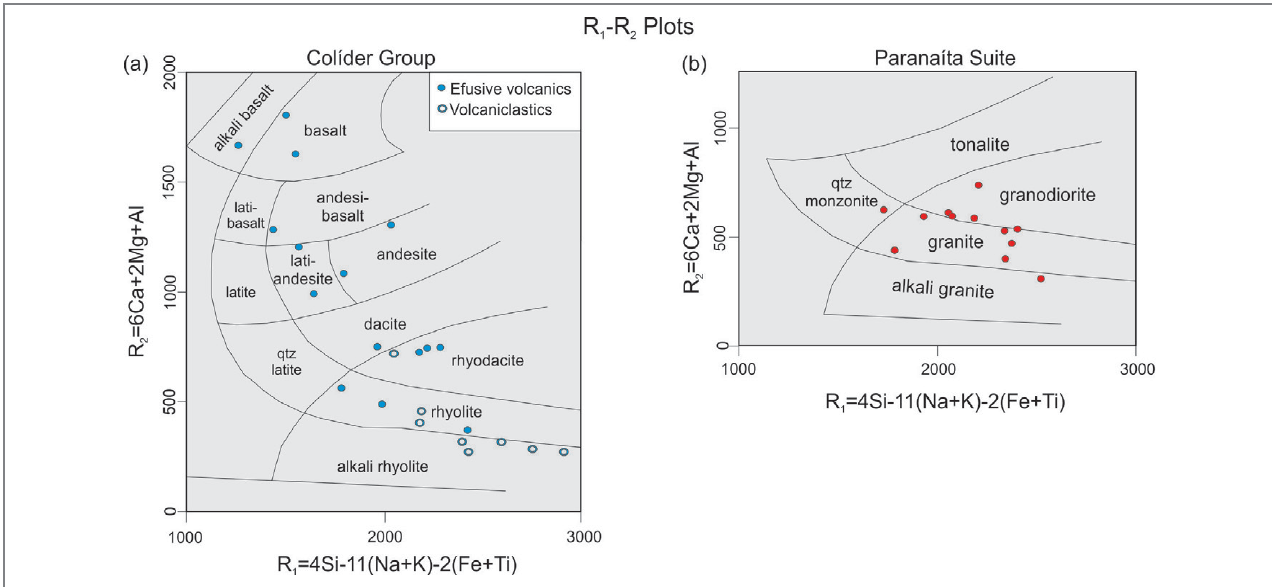
FIGURE 3 - De la Roche et al. (1980) R1-R2 diagrams used for the classification of rock samples from the Colíder Group volcanics (a) and Paranaíta Suite (b).